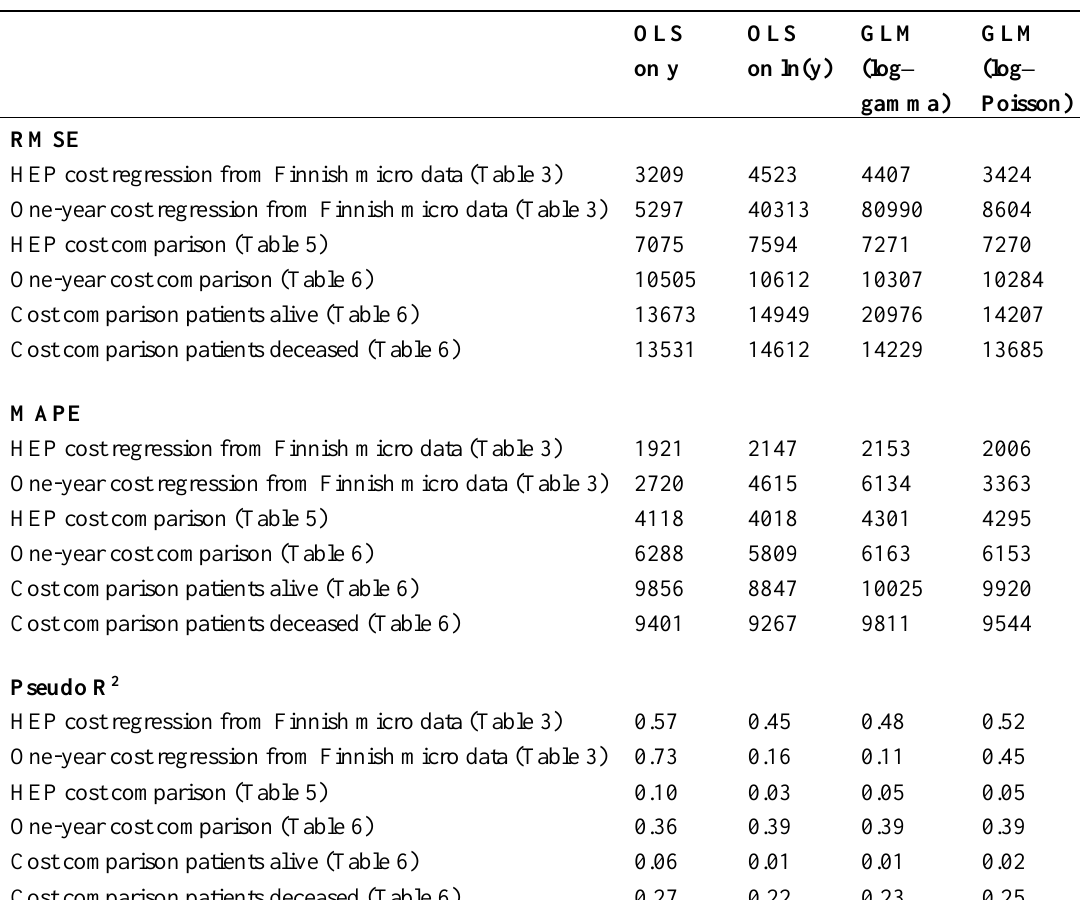
Goodness of fit tests